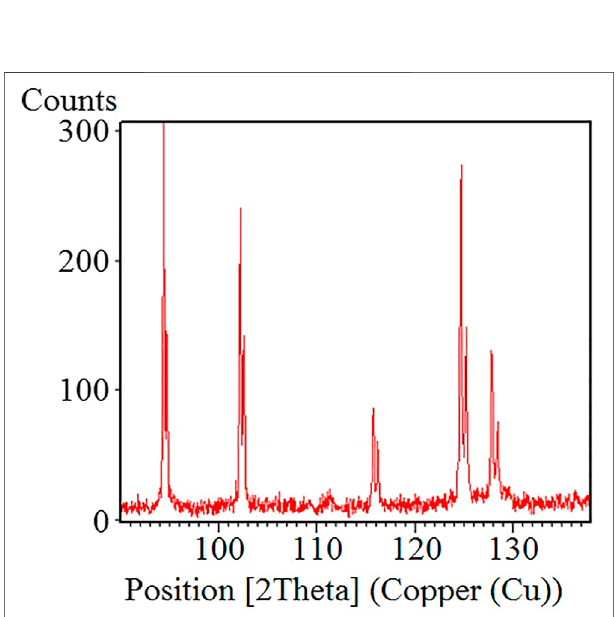
FIGURE 5 | XRD pattern for the electrolyte of the half